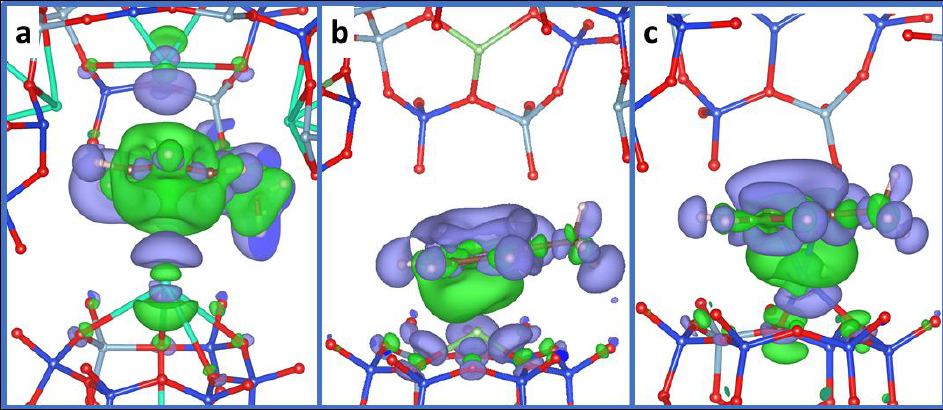
Figure 2. The difference in electron density ( ∆ ρ ) induced by the adsorption of toluene in CsY ( a ), LiY ( b ), and AgY ( c ) faujasites, respectively. The blue (green) zones indicate density increase (decrease). Where cyan balls represent Cs, light green balls represent Li, grey balls represent Ag, blue balls represent Si, and red balls represent